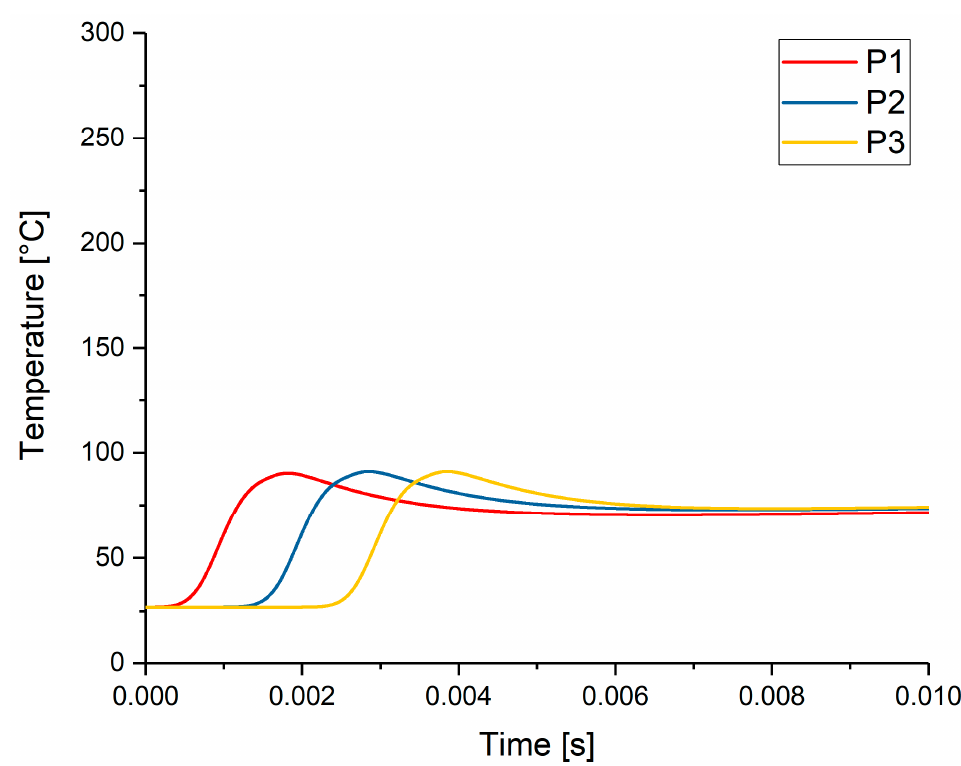
Figure 13. Time–temperature history for the three temperature probes, P1–P3, with solder and silicon included in the model.